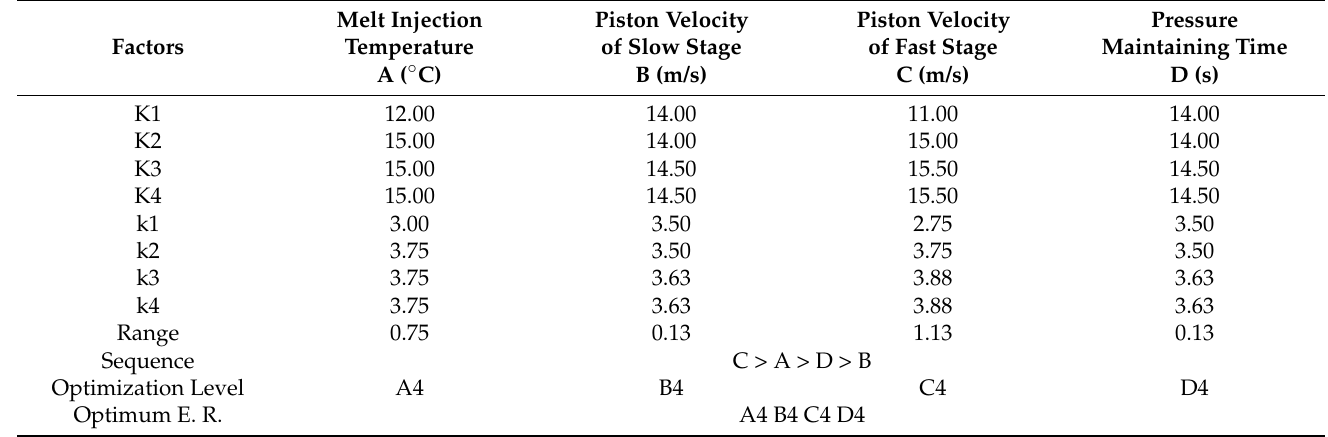
Table 5. The analysis table of filling capacity by means of range analysis